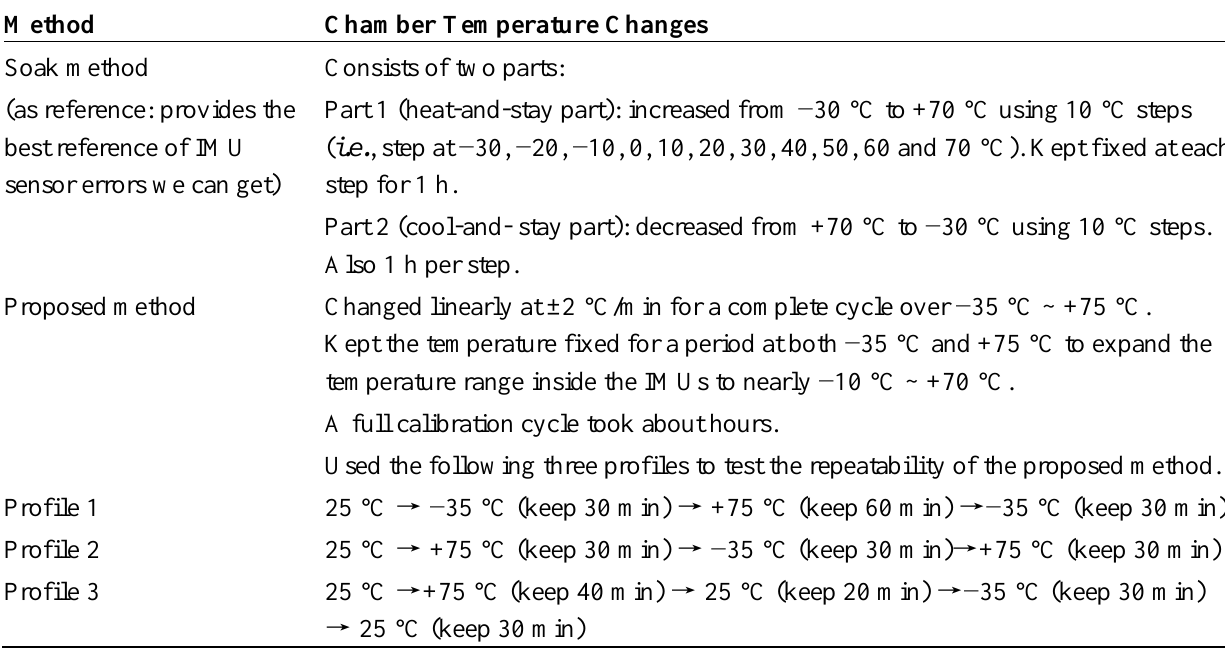
Table 2. Description of temperature changes in tests of both Soak and proposed method. Method